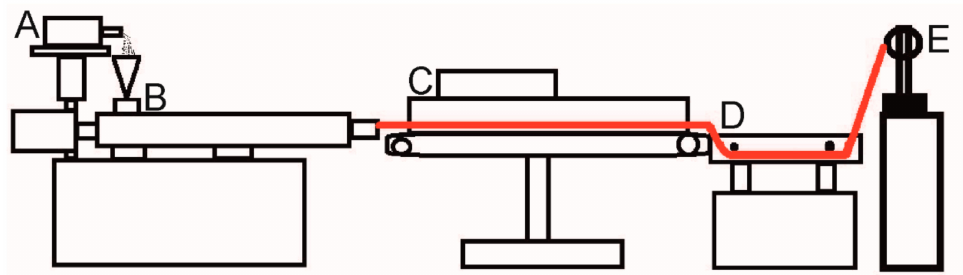
Figure 1. Technical drawing of an extrusion line as used for the production of PEU filaments: Material feeding system ( A ), twin screw extruder ( B ), conveyor belt ( C ), water bath ( D ), and filament winding machine ( E ). The extrudate is drawn in red.